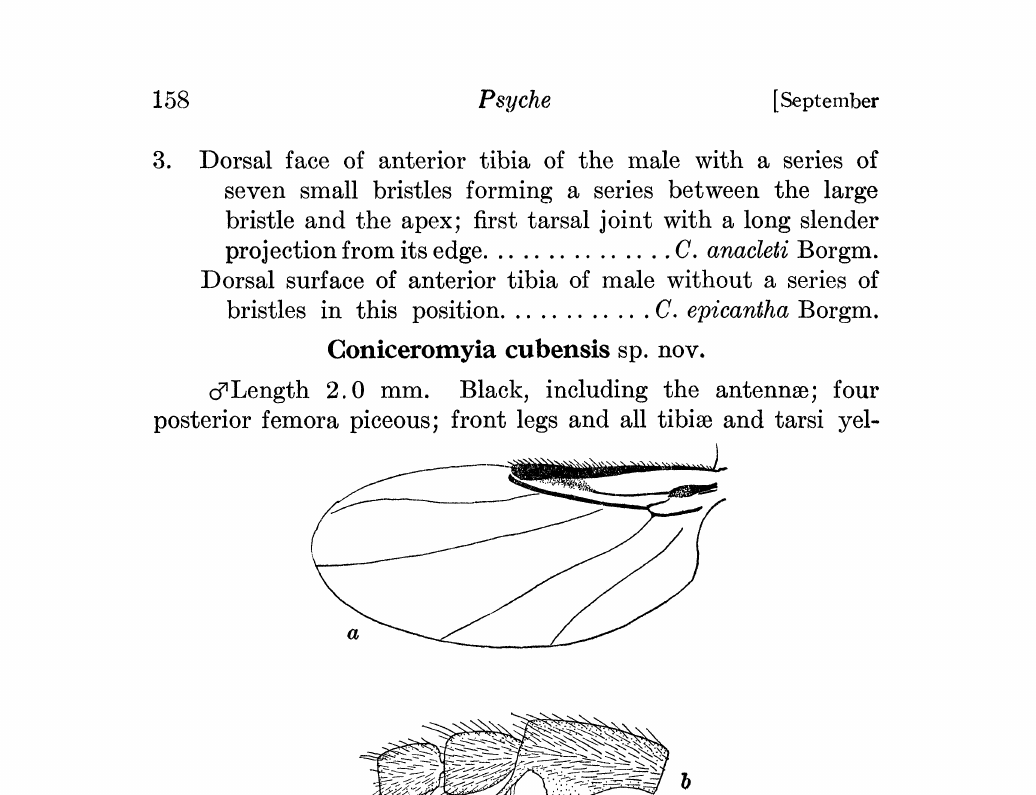
Fig. 1. Coniceromyia cubensis sp. nov. a, wing; b, base of front tarsus. lowish brown; halteres white; palpi yellow. Wings hyaline,